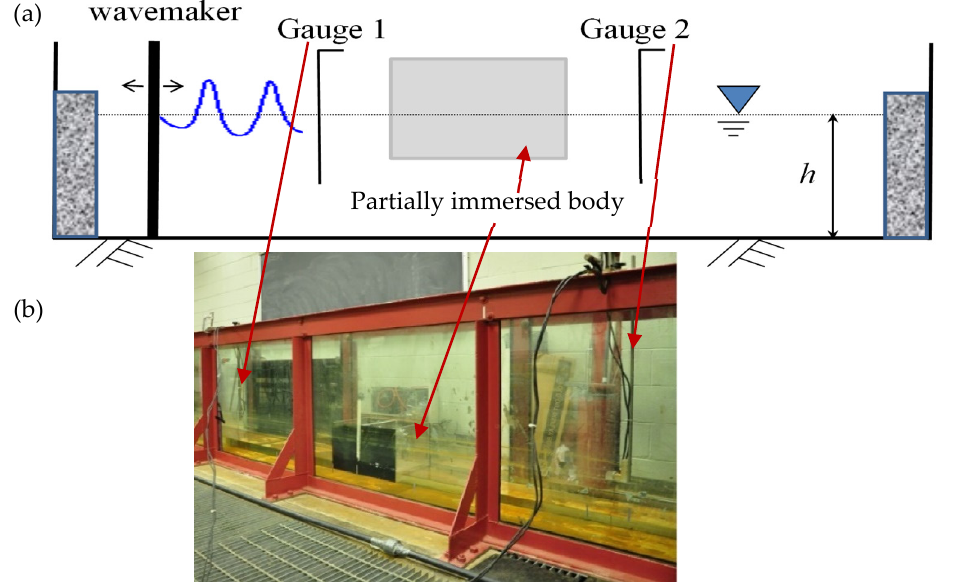
Figure 2. ( a ) Laboratory diagram showing the measurements of wave elevation at Gauge 1 for the incident and reflected waves and Gauge 2 for the transmitted waves. ( b ) Photo showing a partially submerged body and wave gauges in the wave tank.